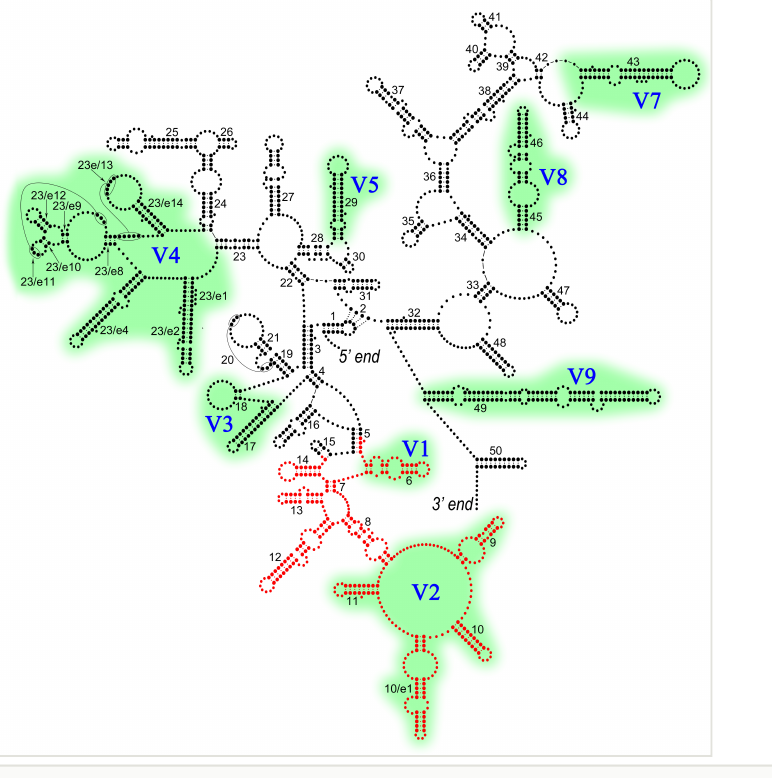
Figure 1. Barcoding region marked in red on the generalized secondary structure model of the nematode 18S rRNA (modi fi ed from Holovachov et al. 2015 with the permission from the publisher). Helices (1-23, 23/e1-23/e14, 24-50) are numbered according to Wuyts et al. (2002). Variable regions V1-V5 and V7-V9 (shaded in green) are numbered according to Neefs et al.